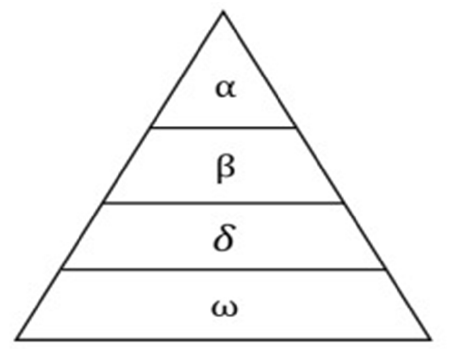
Figure 6. Hierarchy of wolves in GWO.